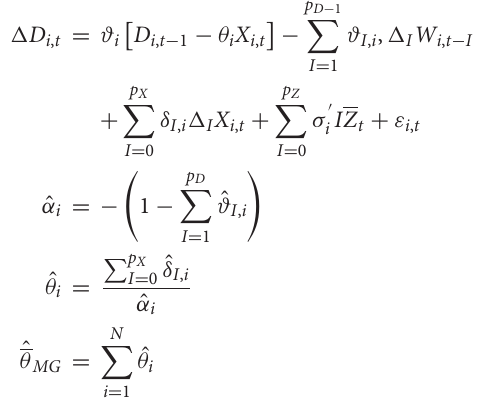
growth (GGR) are 0.926 and 1.326 respectively, indicating narrow variation in observations from mean. The mean value of emissions (EMS), while SD value is 1.336, which means that observations vary within a narrow range over a period of time across the high-GDP countries. Most of the SD values are found lower, indicating that observation varies from the mean within a small range. The results also suggest that there is little variation in the energy consumption (EC) in the sample countries. Table 3 provides the estimate of CD in residuals, the outcomes suggest that the existence of cross-dependence issue is validated. Furthermore, in order to check the consistent outcomes, we detect the CD issues in each variable for the sample countries. Table 4 reports the summary of the CD test, which indicates that selected variables have CD issues. Moreover, absolute